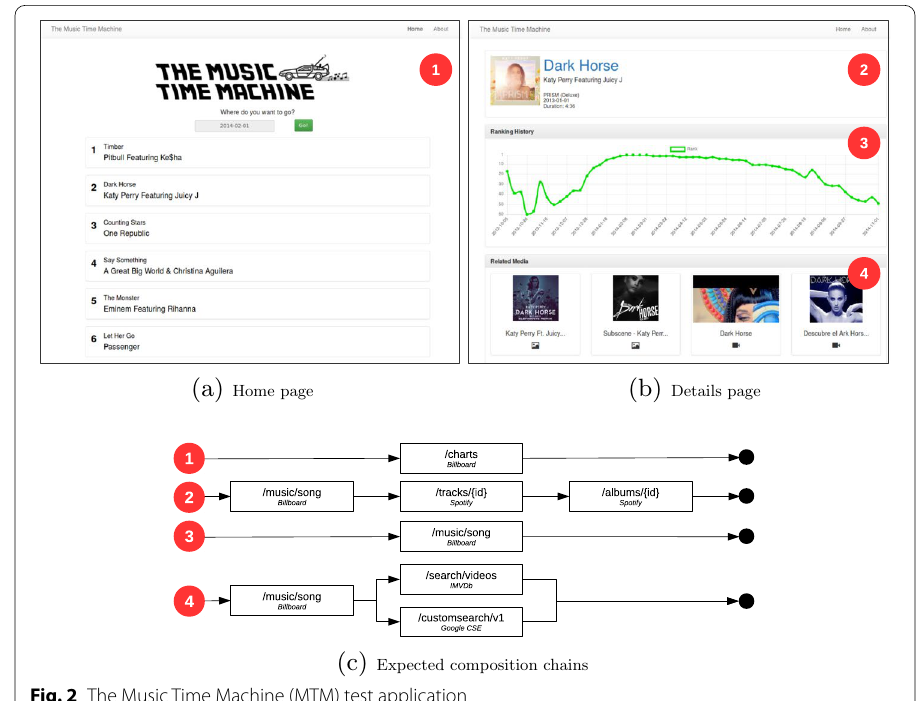
Fig. 2 The Music Time Machine (MTM) test